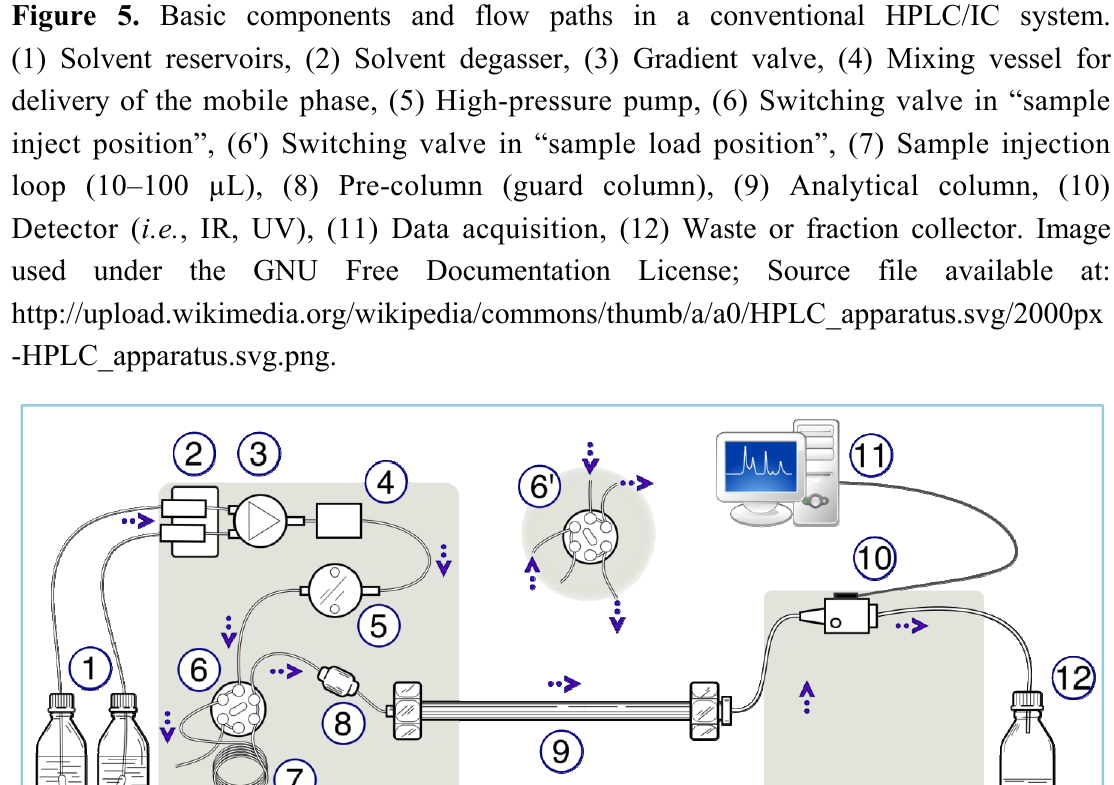
Figure 5. Basic components and flow paths in a conventional HPLC/IC